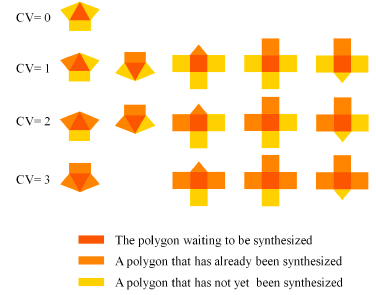
Figure 10. Possible configurations for different constraint values (CVs).